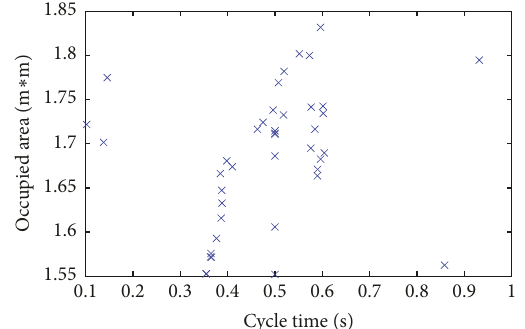
Figure 6: Scatter plot of cycle time and occupied area.